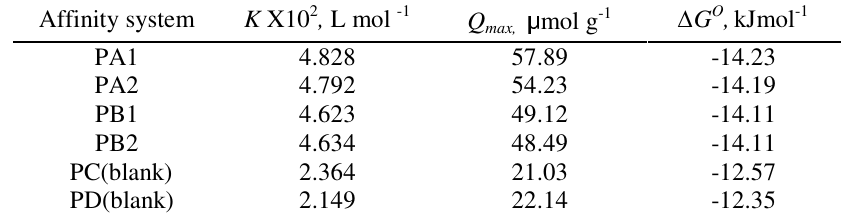
Table 3. Fitted parameters equilibrium constant K, the maximum adsorption capacity ( Q ) , and standard free energy ( (cid:1) G O ) by using the Eq.(4) for Neu5AC on the imprinted max polymers (PA1, PA2, PB1 and PB2) and on the non-imprinted polymers (PC and PD). Affinity